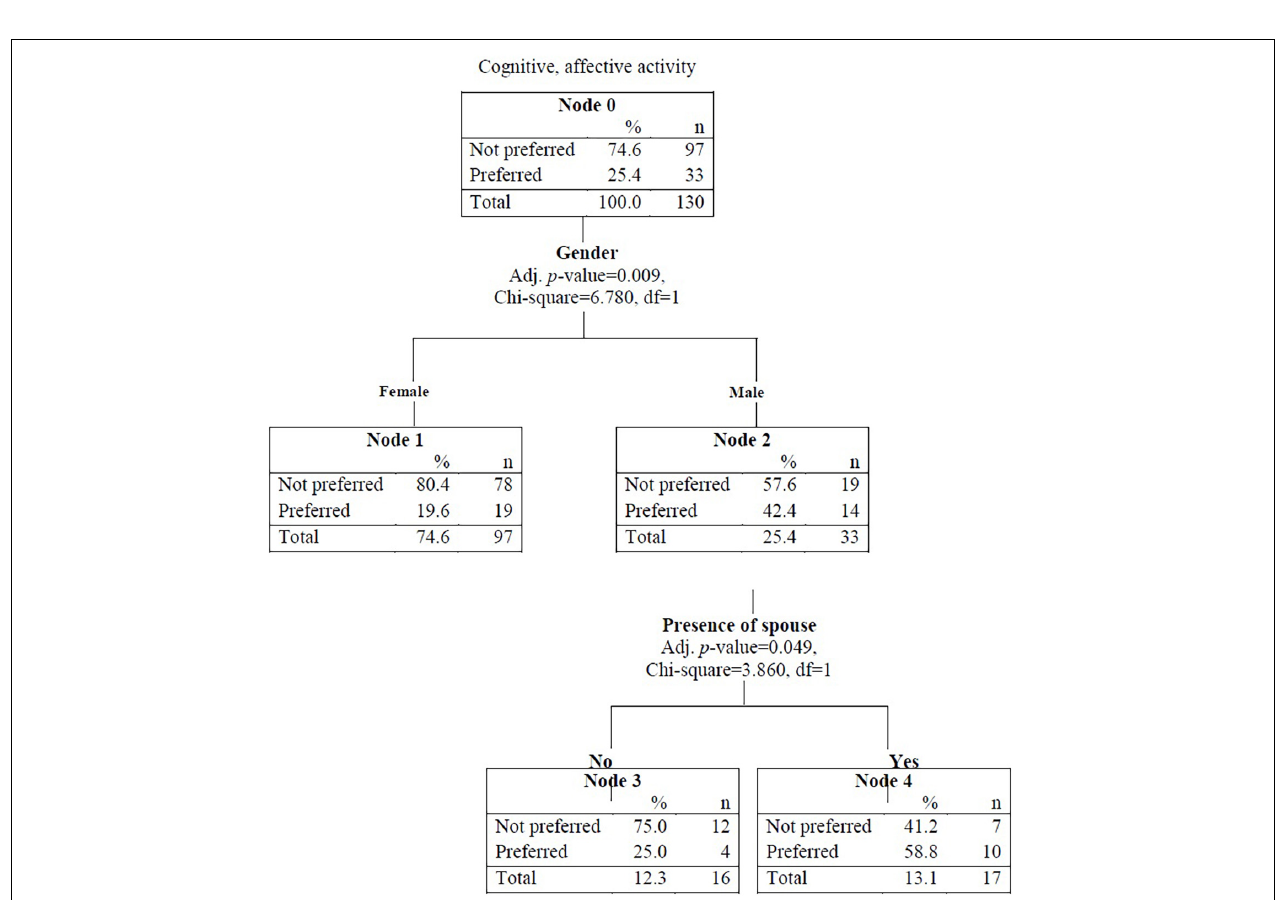
FIGURE 2 | Decision tree for predicting preference in cognitive and affective